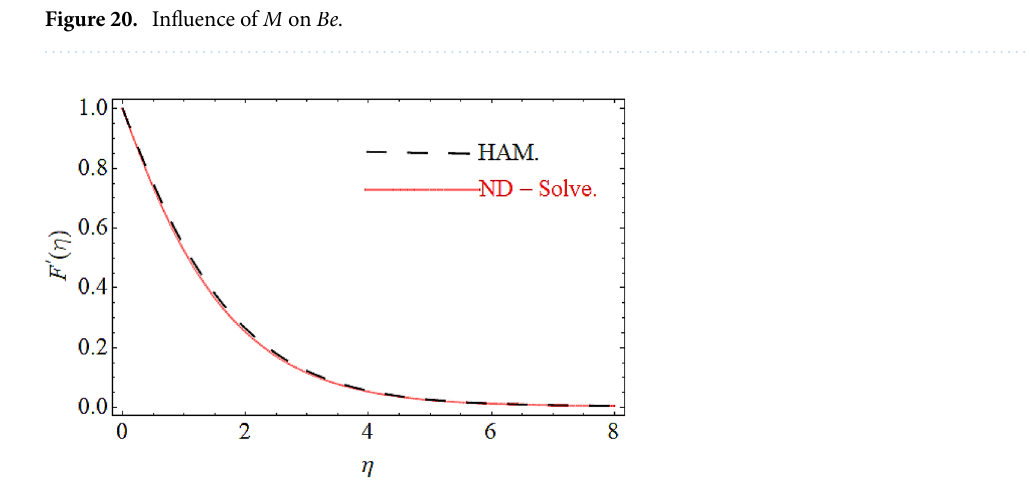
Figure 21. Comparison of HAM and ND-Solve in case of F ′ (η)